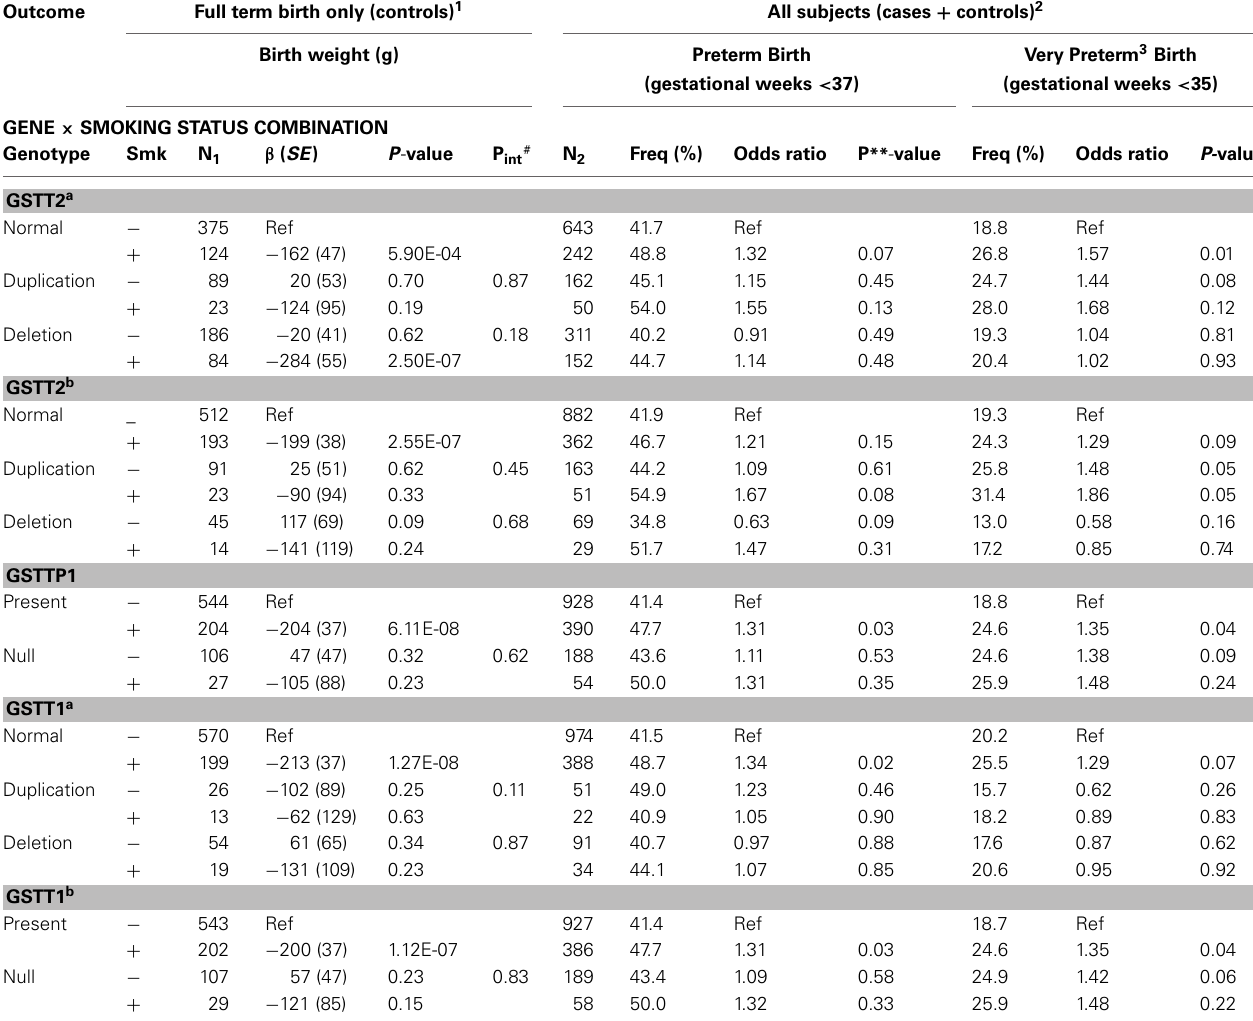
Table 2 | Association of CNVs in GSTT1 / GSTT2 with birth weight and preterm birth. Outcome Full term birth only (controls)